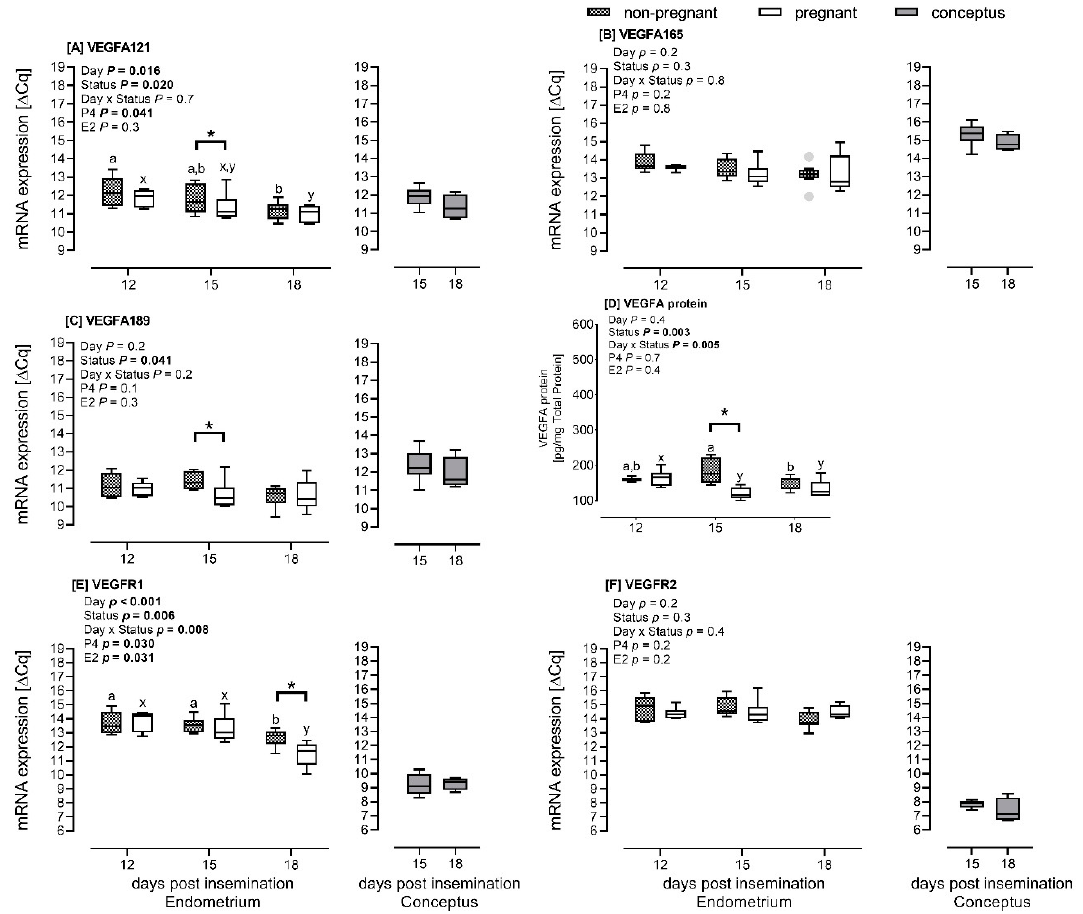
Figure 1. mRNA expression of vascular endothelial growth factor A (VEGFA) isoforms ( A – C ), VEGF receptors ( E , F ) and VEGFA protein abundance ( D ) in the intercaruncular endometrium of nonpregnant ( n = 5 to 8) and pregnant ( n = 5) Simmental heifers at Days 12, 15 and 18 post insemination as well as conceptuses at Days 15 ( n = 8) and 18 ( n = 4) (Insemination = Day 0). Asterisk (*) indicates significant di ff erences between groups and letters significant di ff erences within nonpregnant (a,b,c) and pregnant (x,y,z) groups. Abbreviations: P4 = progesterone and E2 = estradiol-17 β . Results for mRNA expression presented as mean delta quantitative cycle ( ∆ Cq) ± standard error of the mean (SEM). Di ff erences with p < 0.05 were considered as